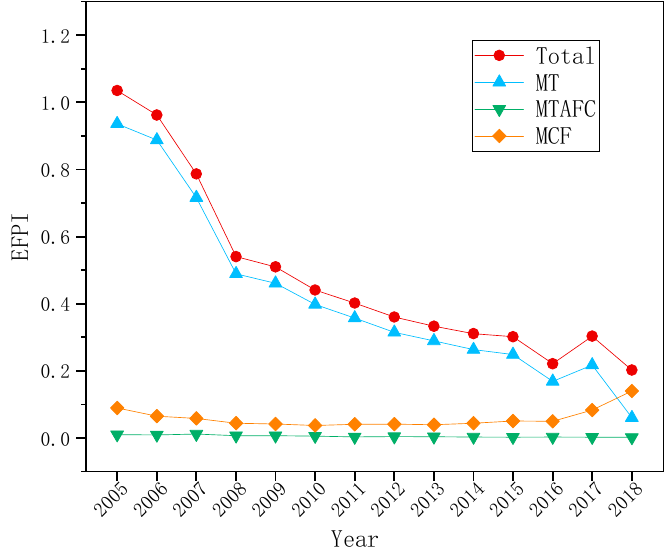
Figure 2. EFPI of Shaoxing’s textile industry and the subsectors during 2005–2018.